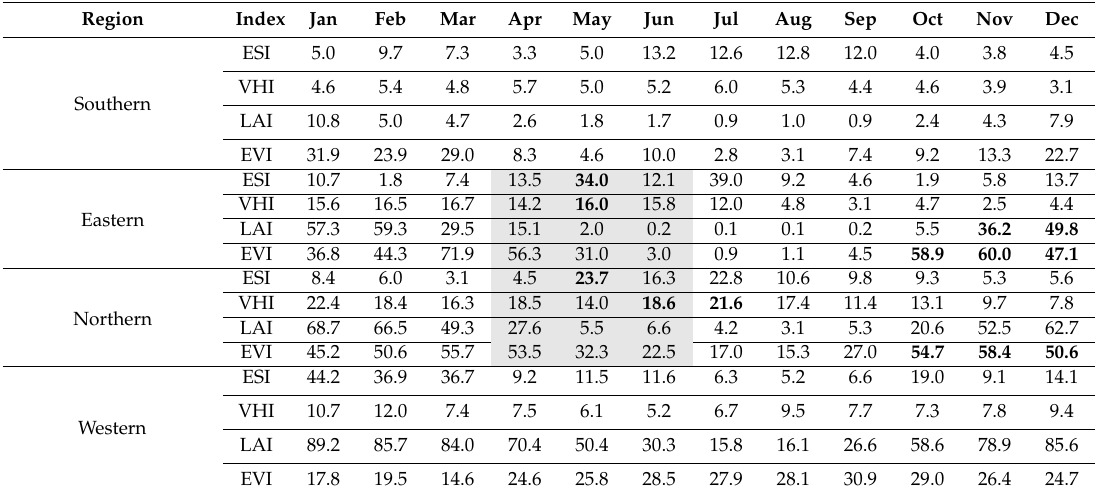
Table 5. Comparison of drought rate by region and actual drought periods, China, 2017 (%).